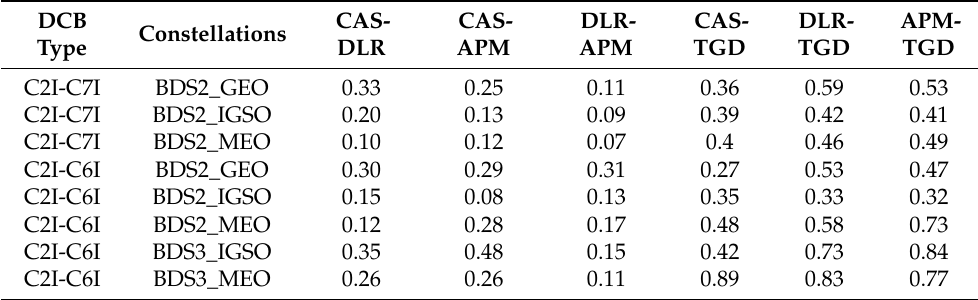
Figure 7. The average differences among the different DCB solutions during the period of DOY 061–244 in 2020. Table 7. The average RMSs of the differences among the different DCB solutions during the period of DOY 061-244 in 2020 (unit: ns).